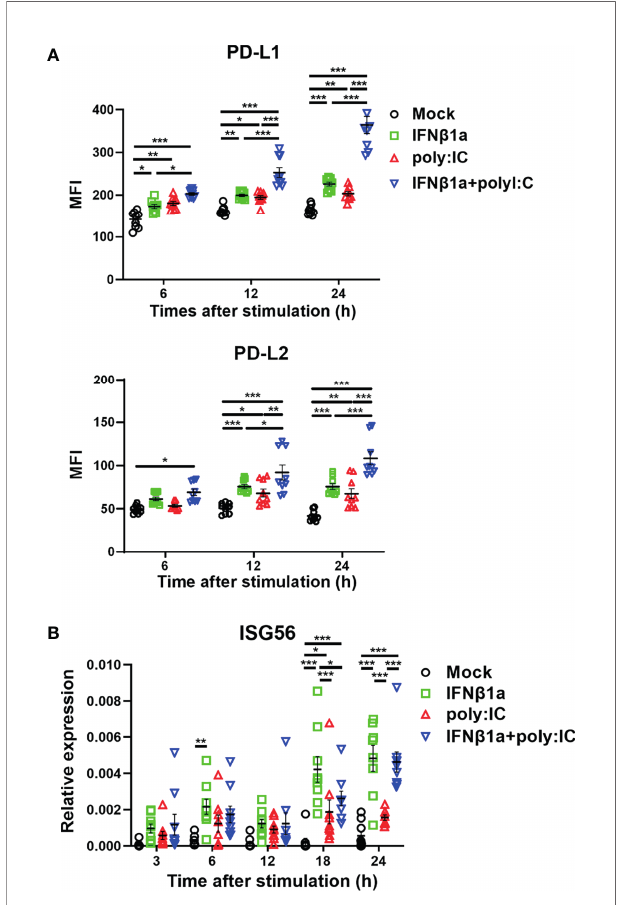
FIGURE 1 | Antiviral interferon increases the expression of PD-L1 and PD-L2 on PBECs. PBECs were pretreated with 250 U/ml IFN b 1a or vehicle for 1 h and then stimulated with 1 m g/mL poly I:C. (A) PD-L1 expression and PD-L2 expression were analyzed at the indicated times following stimulation using fl ow cytometry. (B) ISG56 gene expressions were measured at the indicated times by real-time quantitative reverse-transcription PCR and normalized to that of 18S rRNA. Data represent means ± SEM (n=9 per group) and were pooled from three independent donors with three replicates. * p <0.05, ** p <0.01, *** p <0.001 by two-way ANOVA. MFI, mean fl uorescence